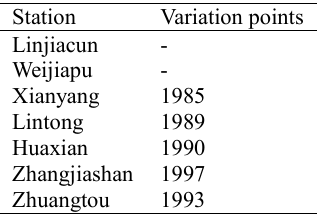
Table 3 Sequential cluster analysis results.